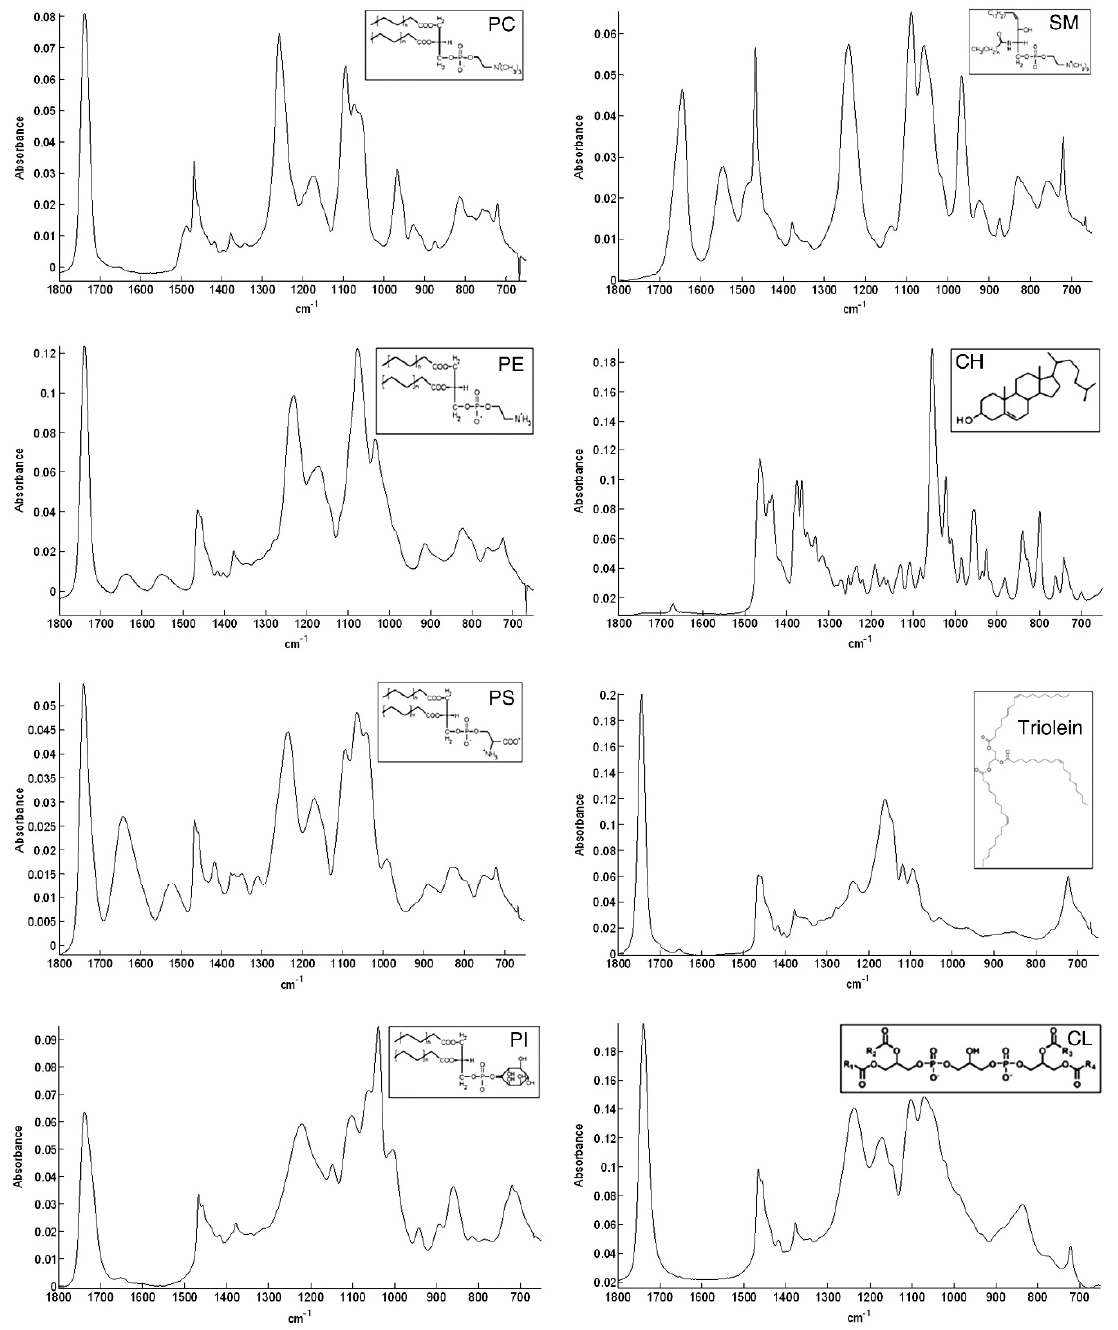
Figure 3. ATR spectra of different membrane lipids (phosphatidylcholine (PC), 1,2-dioleoyl-sn- glycero-3-phosphoethanolamine (PE), phosphatidylserine (PS), phosphatidylinositol (PI), sphin- gomyelin (SM), cholesterol (CH), triolein, and cardiolipin (CL)) between 1800 and 800 cm − 1 [repro- duced with permission from